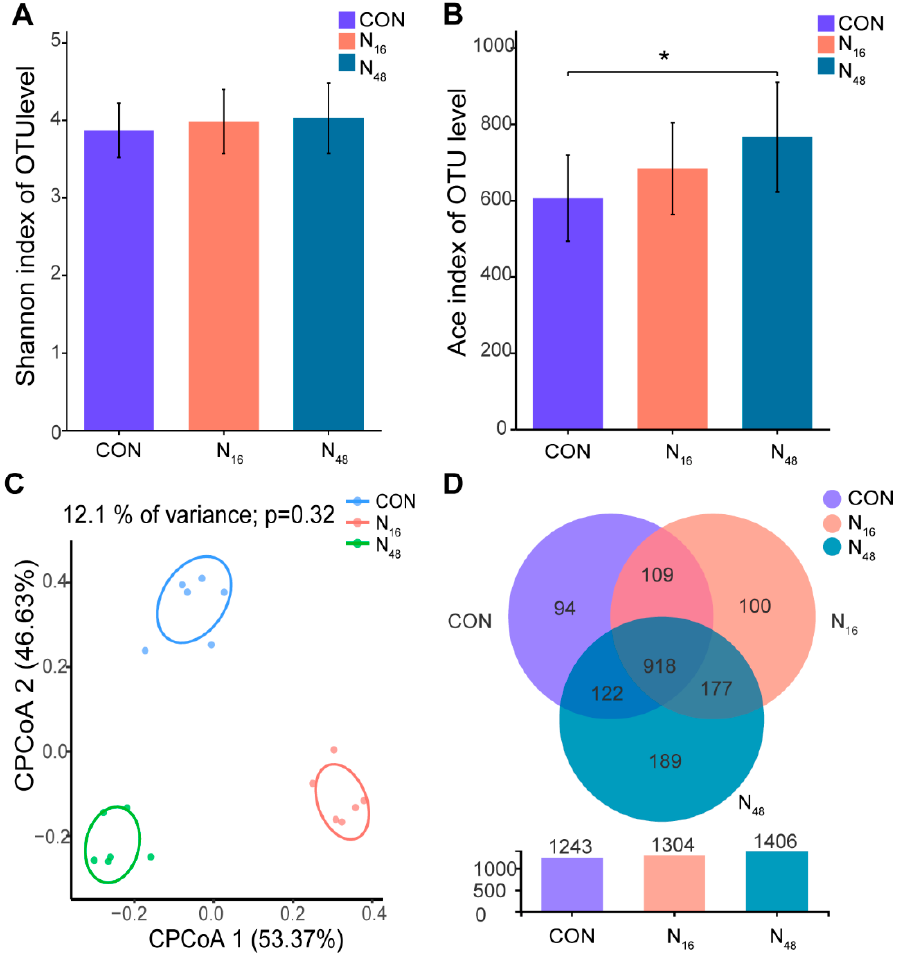
Figure 1. Effects of the fruit of Nitraria tangutorum (FNT) supplement on bacterial composition and structure in rumen fluid in Hu rams. ( A ) Shannon index of the OUT level; ( B ) Ace index of the OUT level; ( C ) CPCoA analysis of a bacterial community, based on OUT; ( D ) Venn diagram of OTUs in the three groups. * p < 0.05.